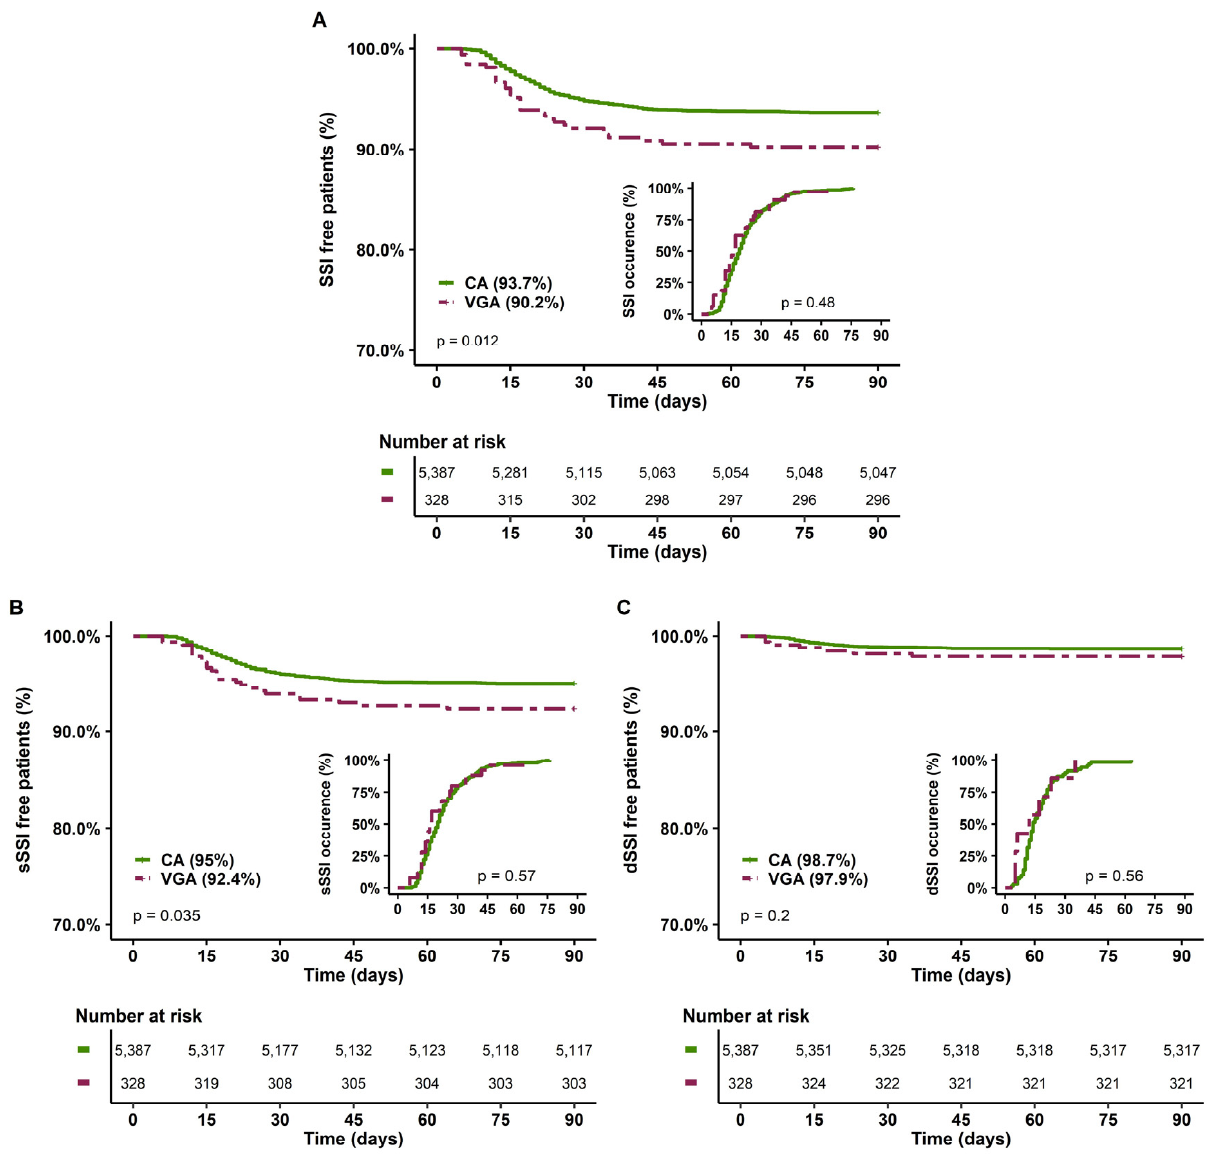
Figure 5. SSI-free patients at 90 days and delay of SSI occurrence according to the type of prophylaxis in the sensitivity analysis restricted to CABG. ( A ) All SSI, ( B ) Superficial SSI; ( C ) Deep SSI. CA, cephalosporin antibiotic prophylaxis; CABG, coronary artery bypass graft, VGA, vancomycin/gentamicin antibiotic prophylaxis; SSI, surgical site infection. Table 6. Multivariate analysis of risk factors for SSI in a sensitivity analysis restricted to CABG.